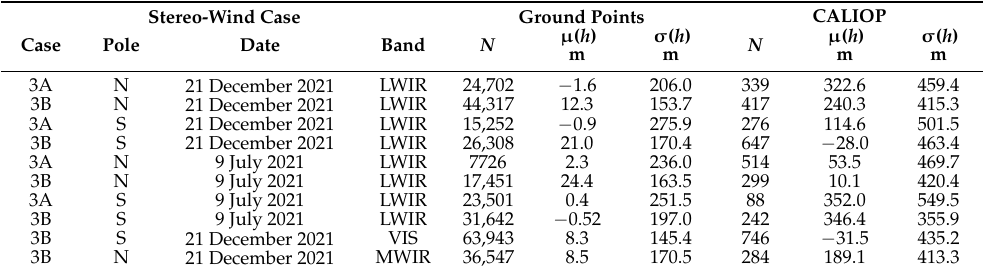
Table 2. Ground-point statistics and CALIOP LiDAR comparisons. The height ( h ) difference means µ and standard deviations σ of each population N are reported for the indicated case.